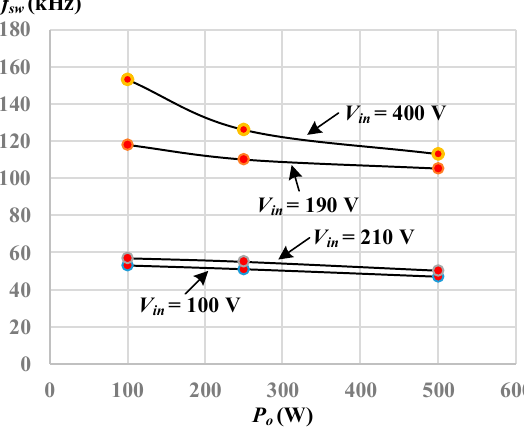
Figure 12. Measured switching frequency under various input voltages and load conditions.